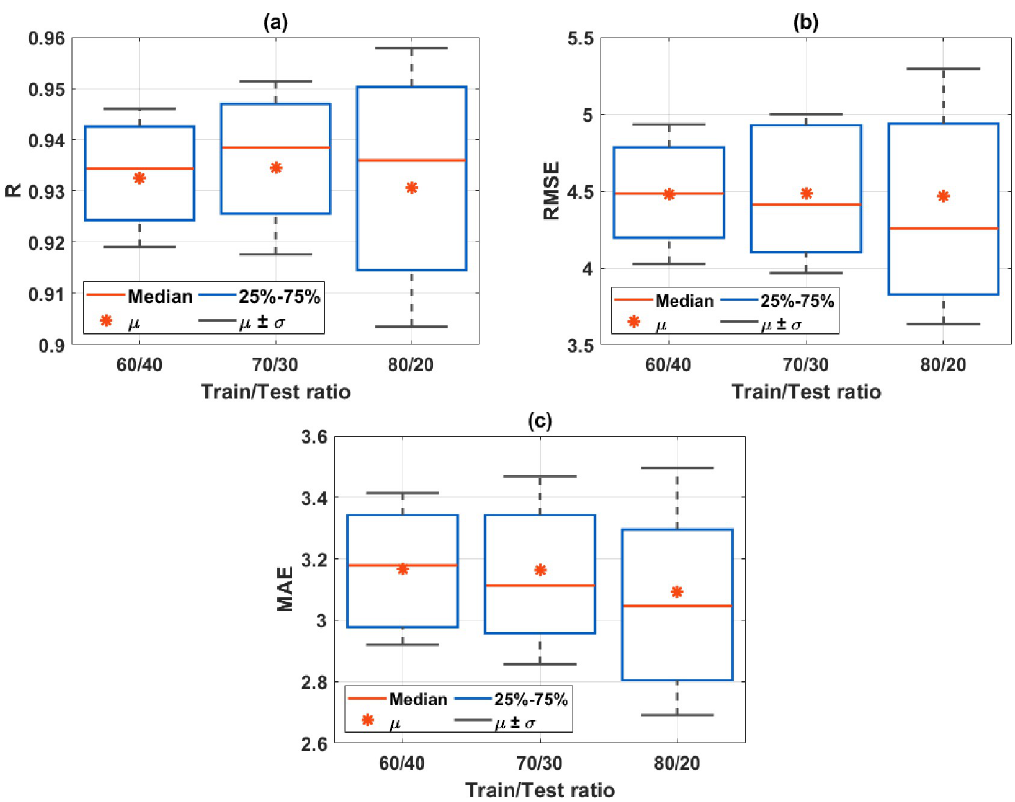
Fig 2. Summary of the prediction performance over 100 simulations using different train-to-test ratios and different criteria: (a) R; (b) RMSE; and (c) MAE, where µ denotes the average value, σ denotes the standard deviation, and 25%-75% denotes the values in the range of the first and the third quartiles,